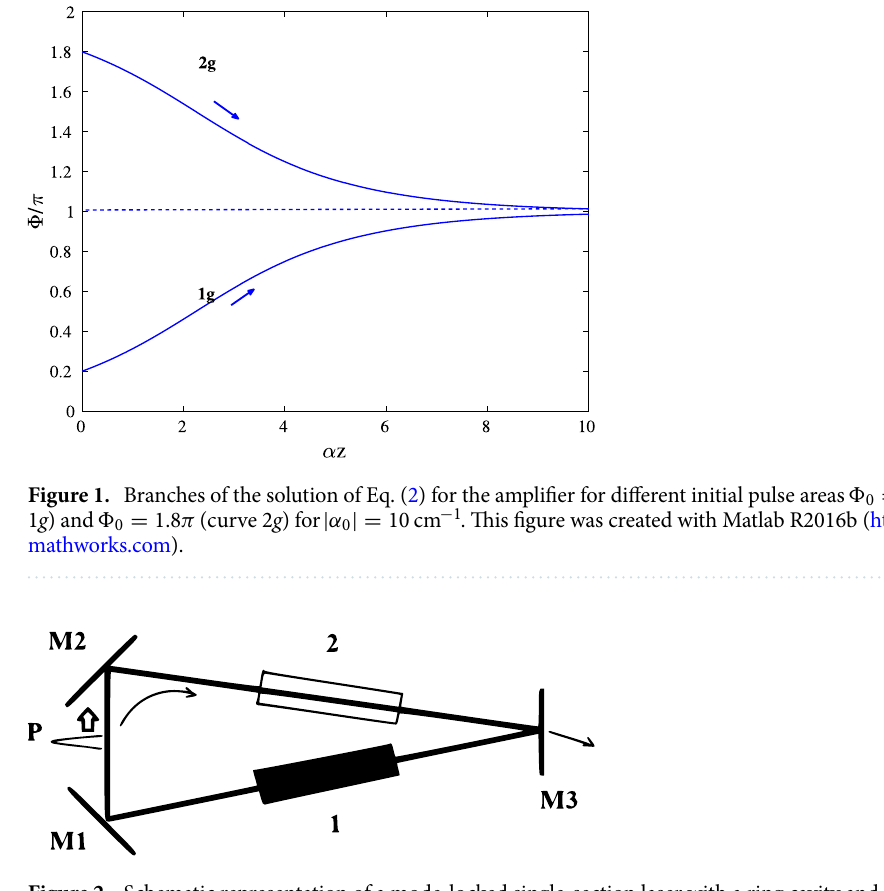
Figure 2. Schematic representation of a mode-locked single-section laser with a ring cavity and unidirectional counterclockwise lasing. 1—amplifying medium, 2—nonreciprocal element, P-pulse travelling in the cavity, M1, M2, M3—cavity mirrors. This figure was created with Paint application for